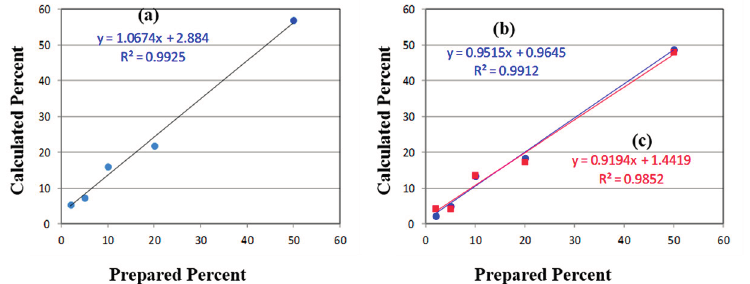
Figure 7. ( a ) Plots of Prepared versus Calculated percentages of p -aminophenol mixed with acetaminophen determined using ( a ) the Raman peak height at 846 cm − 1 ; and the 550–1800 cm − 1 Raman spectral region using ( b ) raw spectra (circles), and ( c ) first derivatives of the spectra (squares). Ideally, the slope should equal 1.0 and the intercepts